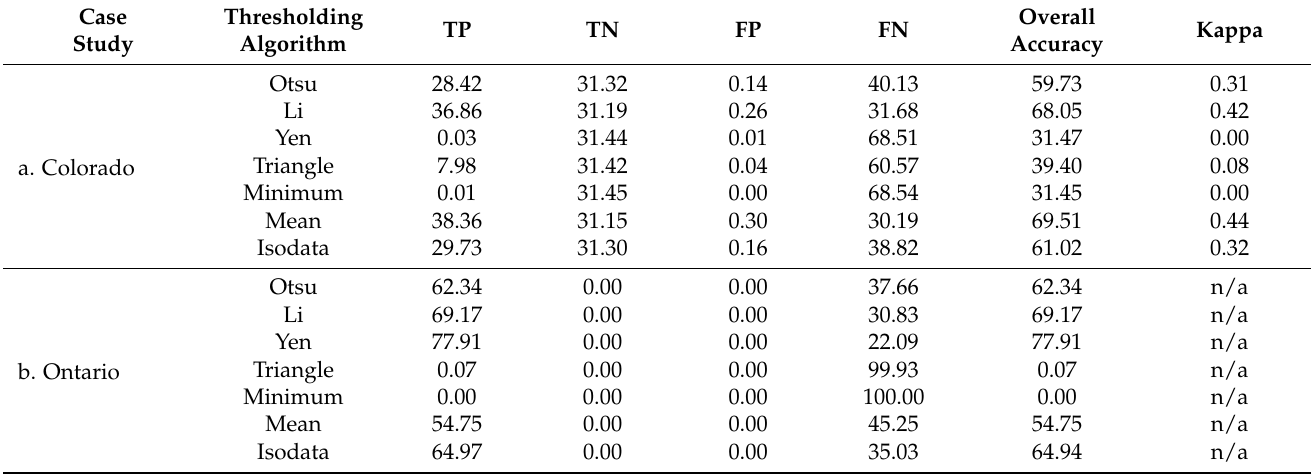
Table 3. Confusion matrix, overall accuracy, errors, and Cohen’s kappa for the seven thresholding algorithms and the four case study